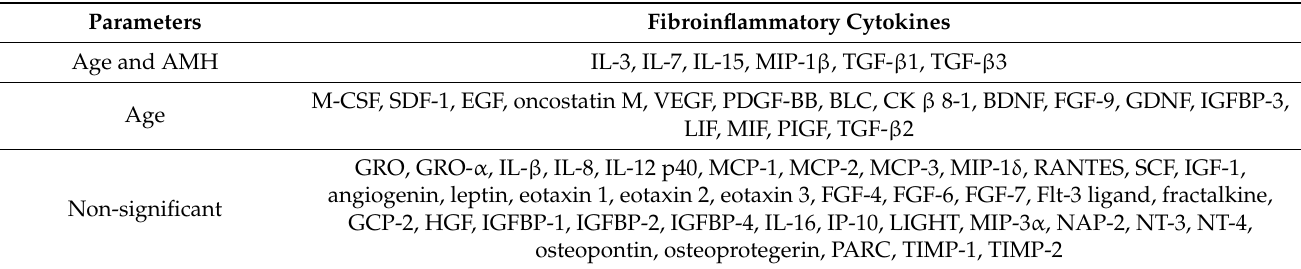
Table 2. Relationship between fibroinflammatory cytokines and biologic and reproductive aging. Parameters